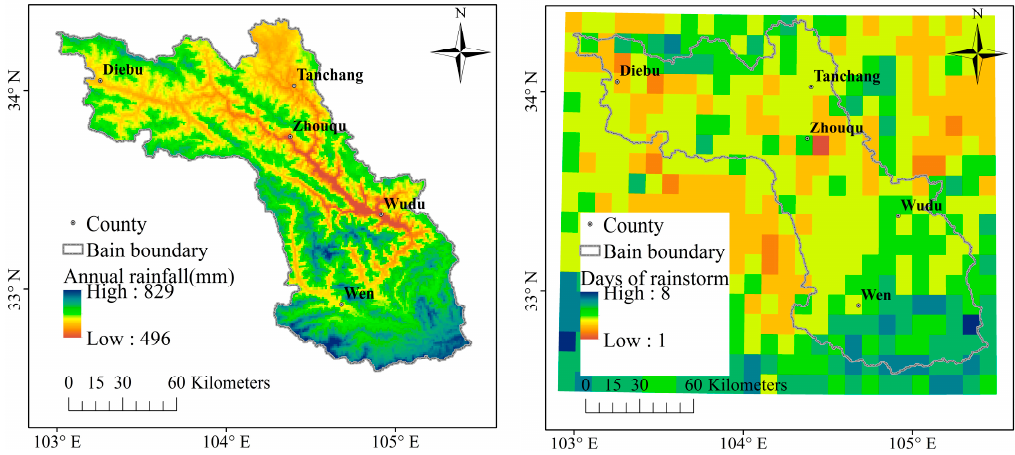
Figure 6. Distribution of factors related to rain conditions.